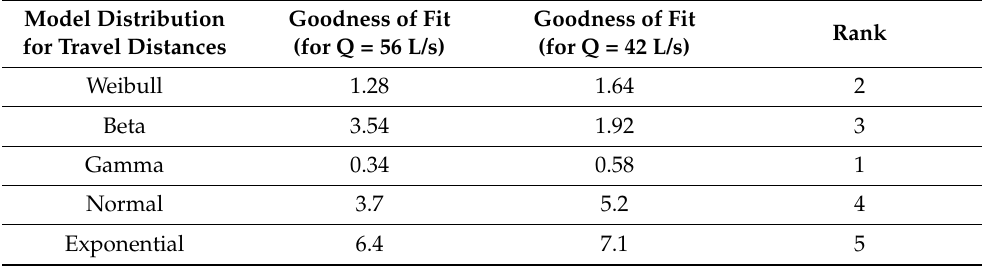
Table 1. Goodness of fit results and corresponding ranking for a range of distributions modelling hop travel distances for the minimum and maximum flow rates used in the experiment.